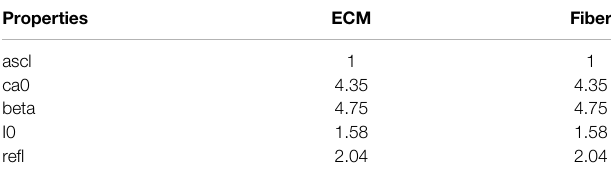
TABLE 2 | Active contraction